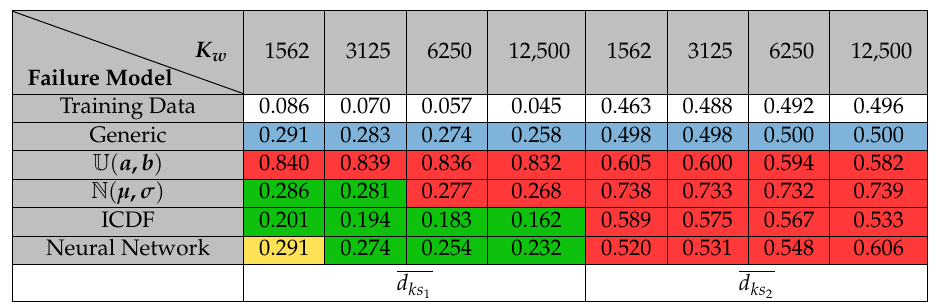
Table 2. Values of d ks sizes K w